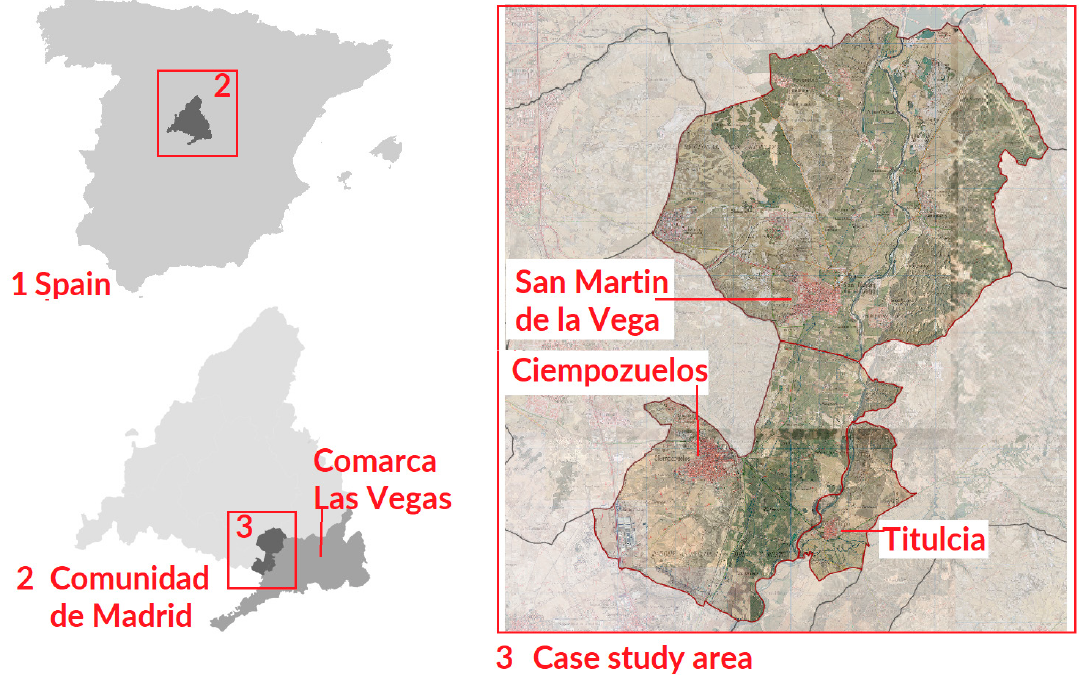
Figure 1. Case Study in Comarca de Las Vegas, Madrid, and Spain. Source: Author.